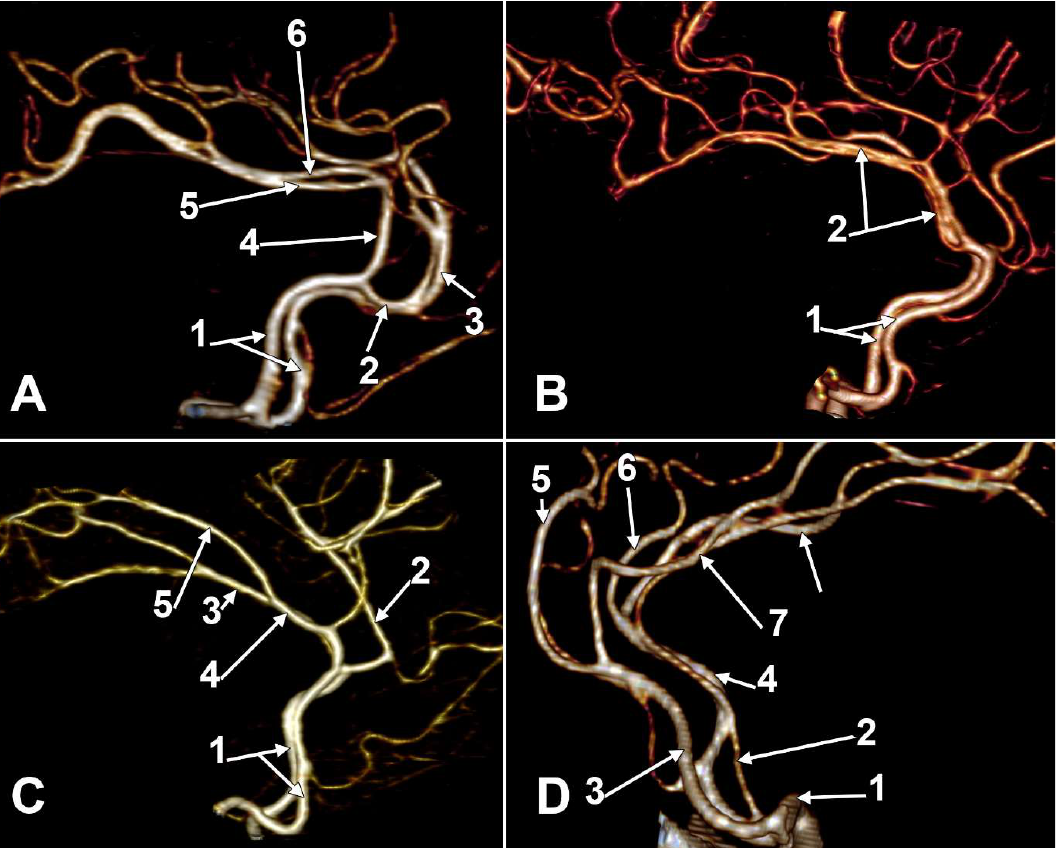
Figure 4. Three-dimensional volume renderings of different types of different branching types of the anterior cerebral arteries (ACAs) into the pericallosal (PCalA) and callosomarginal (CMA) arteries. ( A ) Right lateral view: 1. A2 segments of the ACAs; 2. type 1 right CMA; 3. type 1 left CMA; 4. type 6 PCalA (azygos PCalA); 5. right PCalA; 6. left PCalA. ( B ) Right lateral view: 1. A2 segments of the ACAs; 2. type 5 (duplicated) right PCalA. ( C ) Right lateral view: 1. A2 segments of the ACAs; 2. left CMA; 3. left PCalA; 4. type 9 right PCalA; 5. right cingular branch. ( D ) Left lateral view, type 11—triple PCalA: 1. A1 segment of bihemispheric right ACA; 2. median callosal artery; 3. left A2 segment; 4. right bihemispheric A2 segment; 5. left CMA; 6. right CMA; 7. left PCalA; 8. right PCalA. Table 1. Types of pericallosal (PCalA) and callosomarginal (CMA) arteries that were found in 90